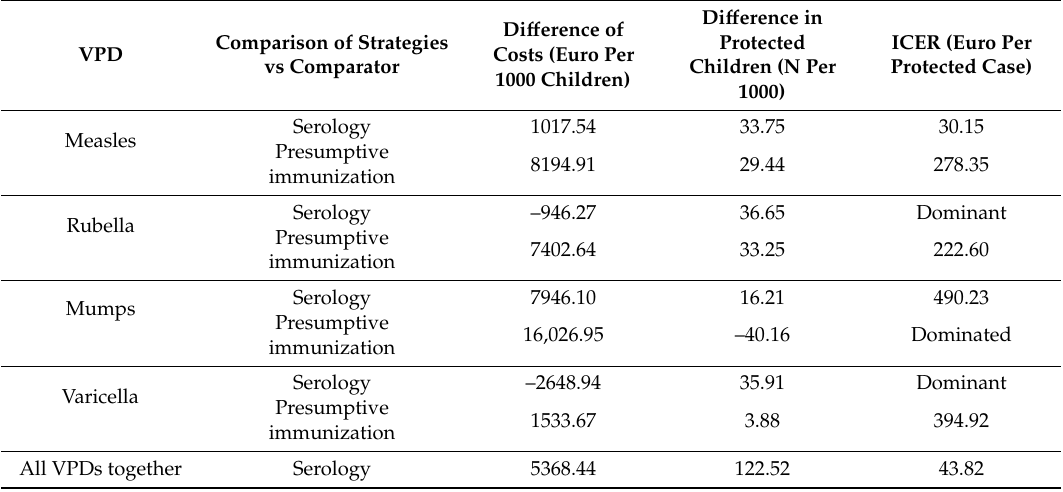
Table A4. Comparison of strategies according to di ff erent VPDs excluding children < 1 year of age (ELISA